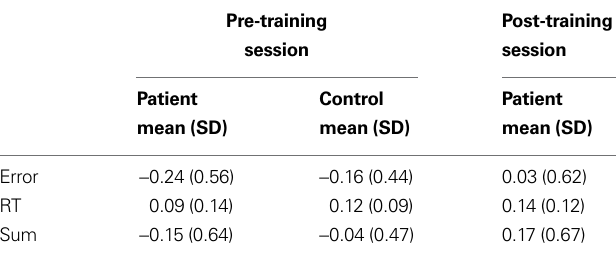
Table 2 | Proportion of errors and reaction times. Table 3 | Context processing scores for Error, RT, and sum of Error and